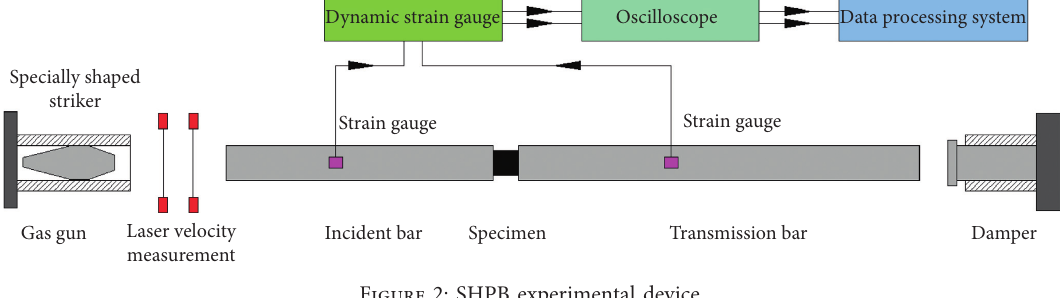
Figure 2: SHPB experimental device.